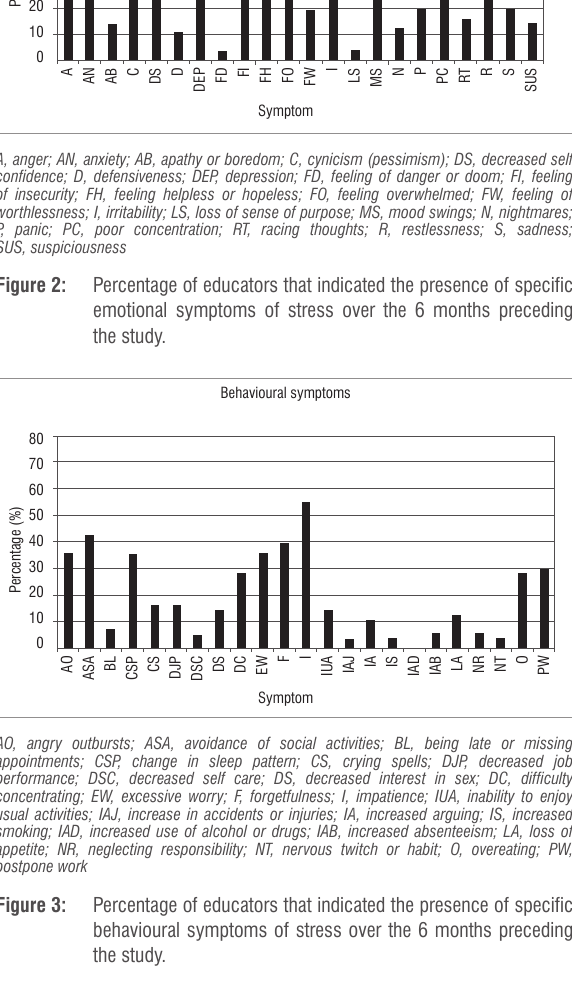
Figure 3: Percentage of educators that indicated the presence of specific behavioural symptoms of stress over the 6 months preceding the